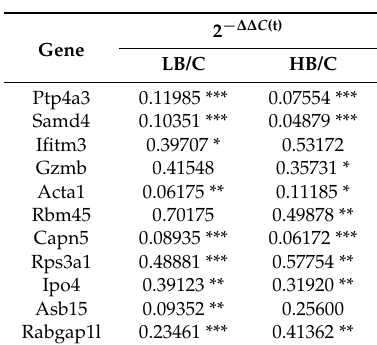
Table 7. Validation of differentially deregulated genes by RT-PCR.